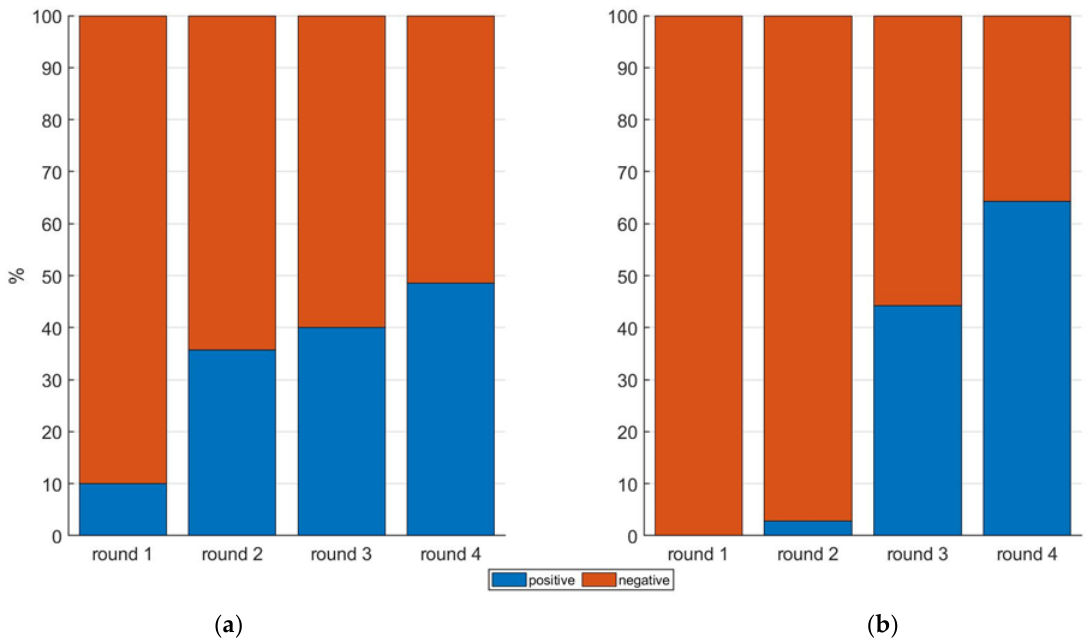
Figure 6. BC model ( a ) and ANN-AP ( b ) test results in round 1, 2, 3, 4. The binary classification results on unlabeled datasets show two classes, respectively, infected (positive) and healthy (negative). The two models were trained on round 5 with a threshold infection rate of 0.51%; therefore, the number of positive samples and negative in the training set resulted in 35 and 35 (50% positive and 50% negative), respectively.